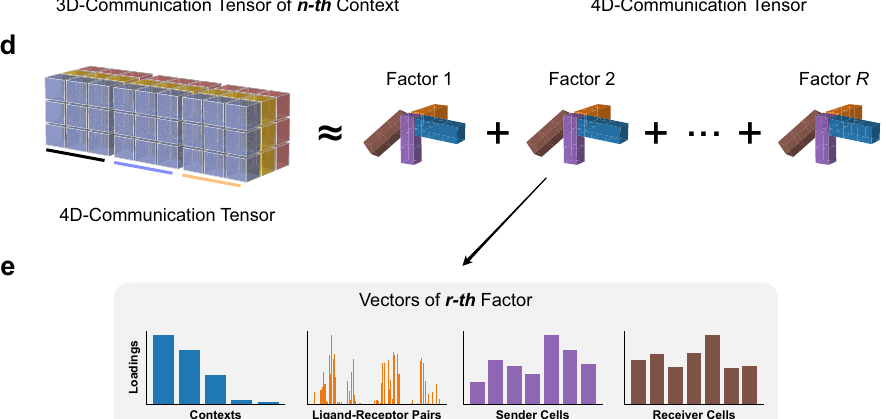
receptor pairs, sender cells and receiver cells assigned as participants of the cognate pattern (Fig. 2g). Indeed, we observed a concordance between the “ ground truth ” LR pairs assigned to a pattern and their respective factor loadings through Jaccard index and Pearson correlation metrics (Supple- mentary Tables 1 – 2). Moreover, Tensor-cell2cell robustly